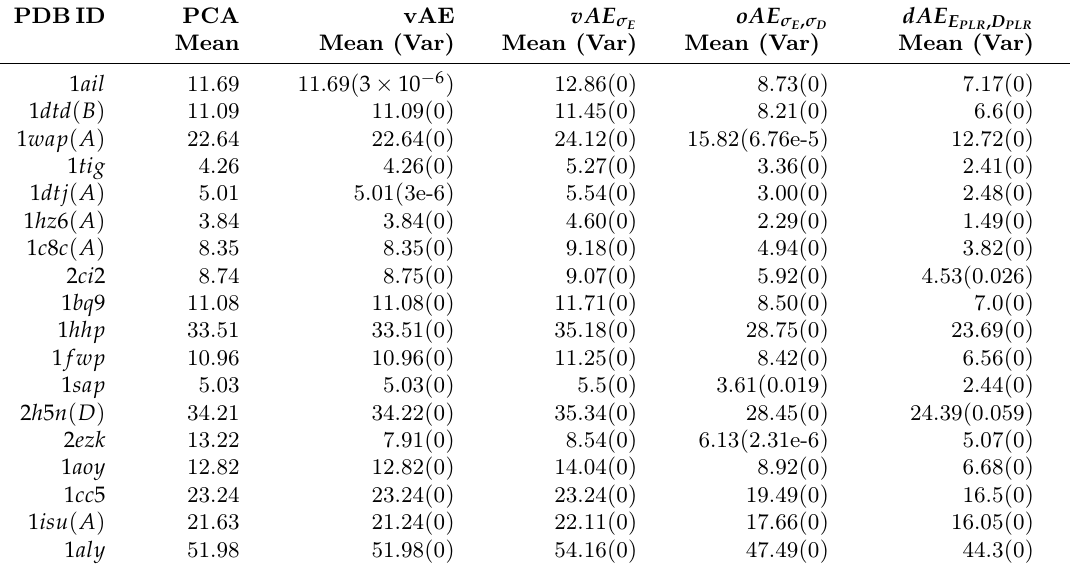
Table 2. Comparison of MSEs of PCA, vAE, vAE σ target proteins; each protein is identified with the PDB id of its known native structure, with the chain shown in parentheses. Each AE architecture is trained three times, starting with initial random weights and biases, resulting in different models, whose MSE variances are shown. The mean MSE values are rounded to the second digit after the decimal sign. Higher precision is shown for the variance results, rounding to 0 all values less than 1 × 10 − 10